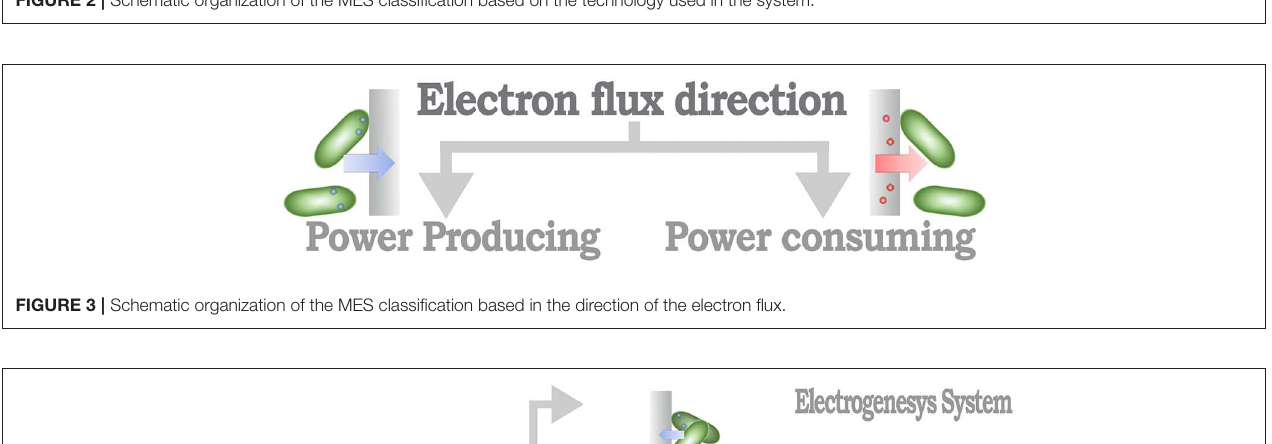
(Bagchi and Behera, 2019); microbial electrosynthesis